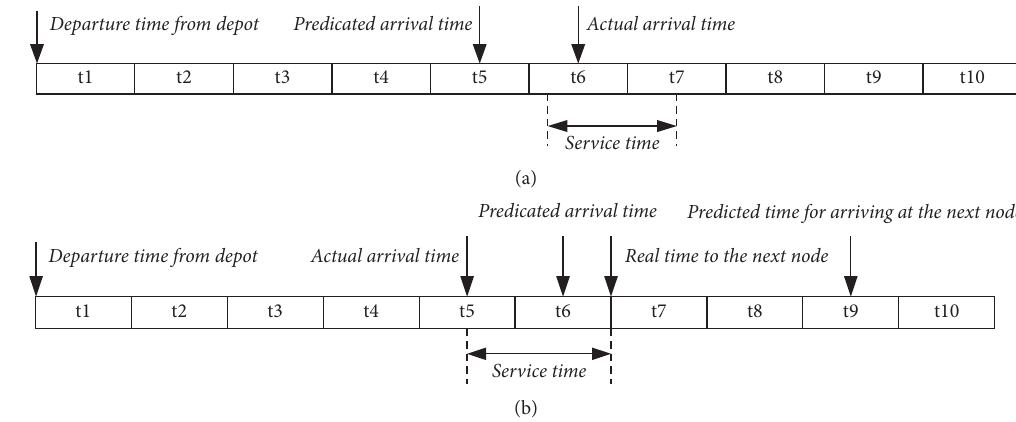
Figure 6: Schematic diagram of real-time calculation. (a) Later than the predicted arrival time. (b) Earlier than the predicted arrival